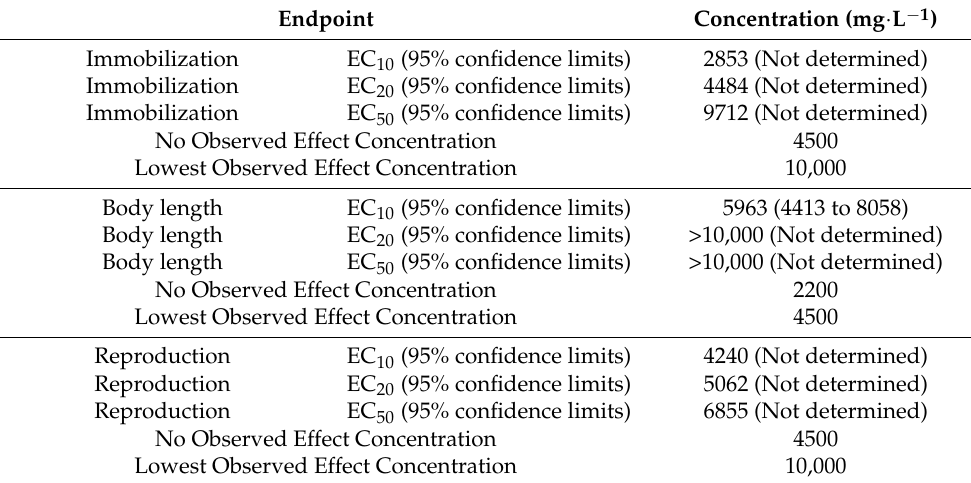
Table 9. Bacillus velezensis Strain B25 Effects on immobilization, body length, and reproduction of Daphnia Magna